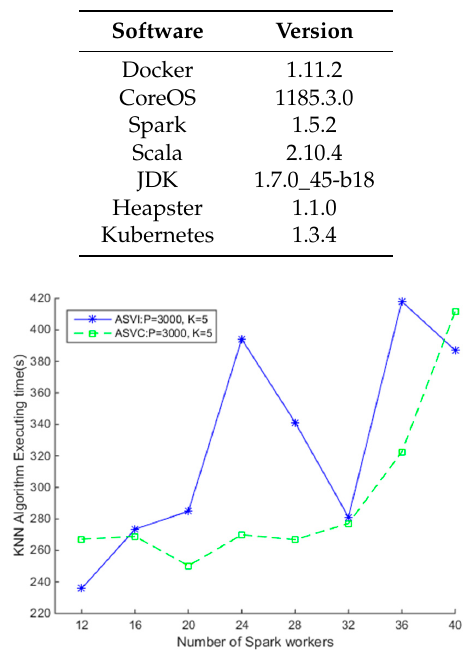
Table 3. The summary table of software used in the following tests.